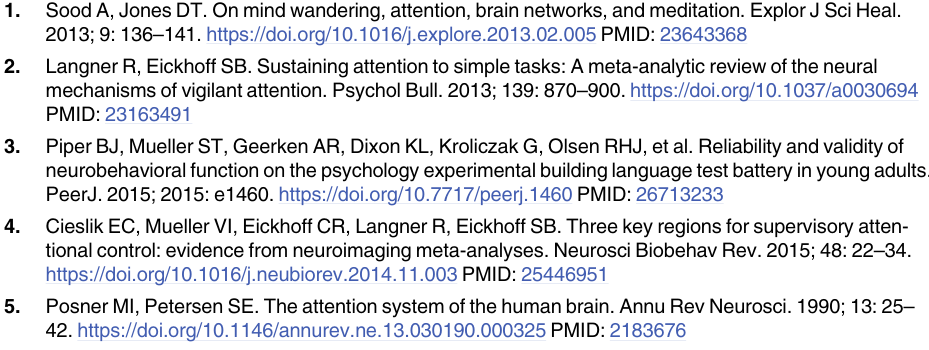
S6 Table. Descriptive statistics for performance measures of the Mental Rotation task. S7 Table. Descriptive statistics for performance measures of the Attentional Network Test. S8 Table. Statistics of significant main effects and interactions across sites and post-hoc